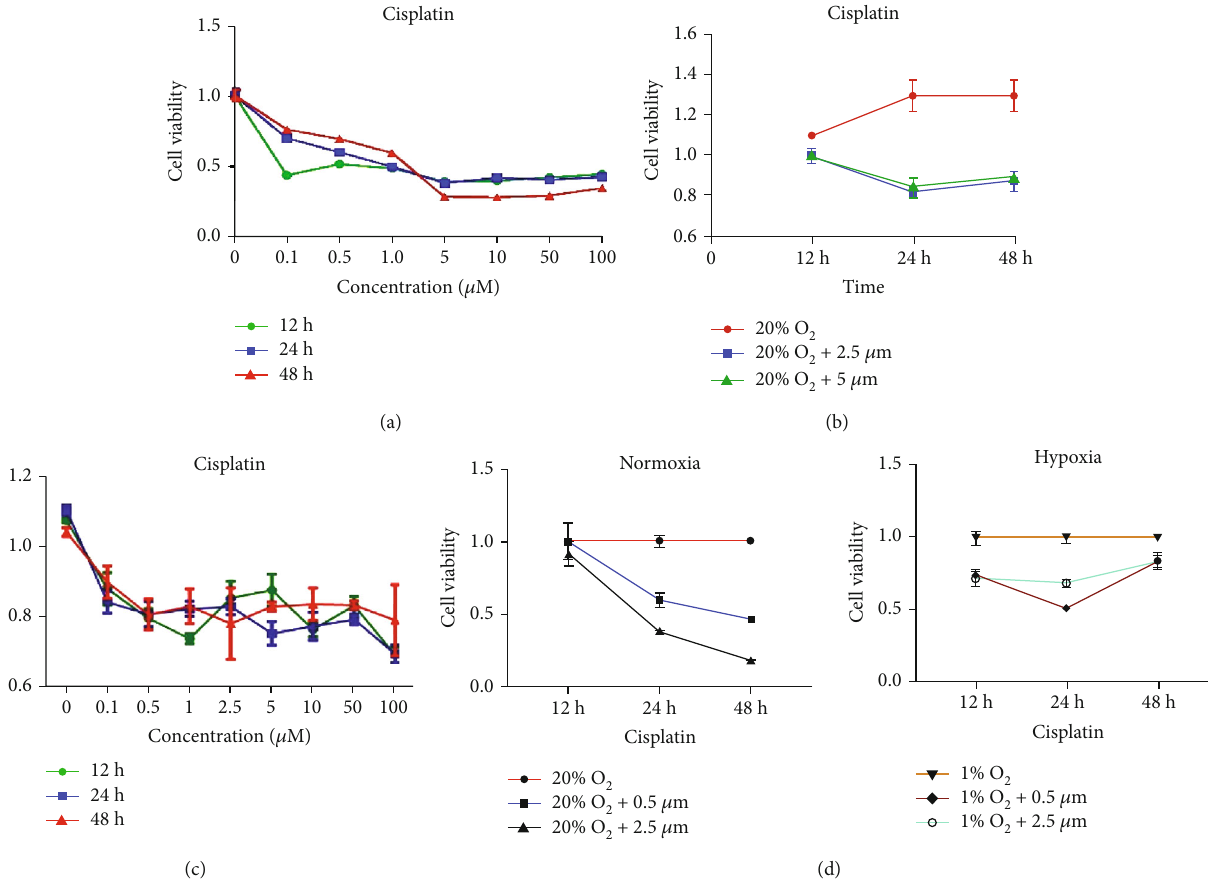
Figure 1: Hypoxia reduced chemosensitivity of bladder cancer cells to cisplatin. (a) Viability of bladder cancer cells was measured after treatment with graded concentrations of cisplatin at 12, 24, and 48 h. (b) Cell viability was further observed after treatment with 2.5 and 5.0 μ m cisplatin under normoxia. (c) BIU-87 cancer cells were cultured under hypoxic conditions with di ff erent concentrations of cisplatin for 12, 24, and 48 h. (d) Viability of cells incubated with cisplatin was reversed under hypoxia compared with that under